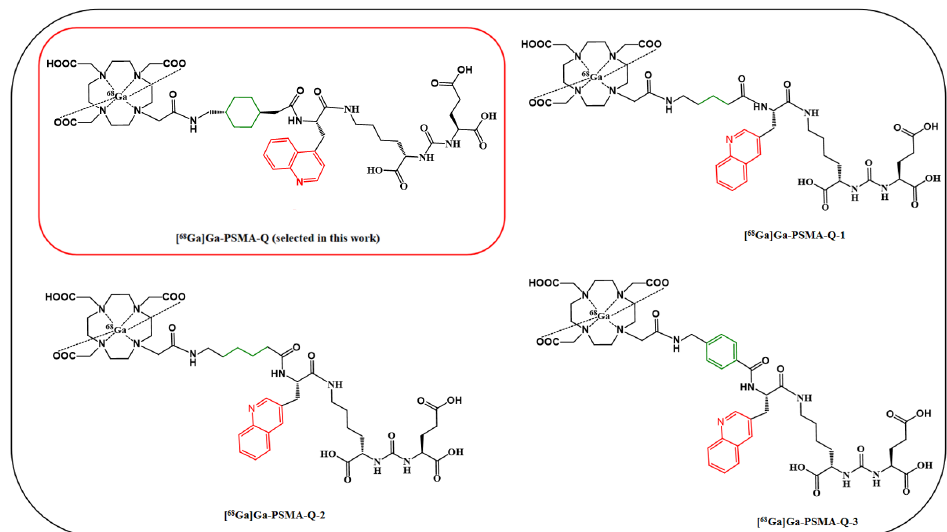
Figure 1. The chemical structures of [ 68 Ga]Ga-PSMA-617, [ 68 Ga]Ga-PSMA-11, [ 68 Ga]Ga-PSMA-Q, [ 68 Ga]Ga-PSMA-Q-1, [ 68 Ga]Ga-PSMA-Q-2, and [ 68 Ga]Ga-PSMA-Q-3.